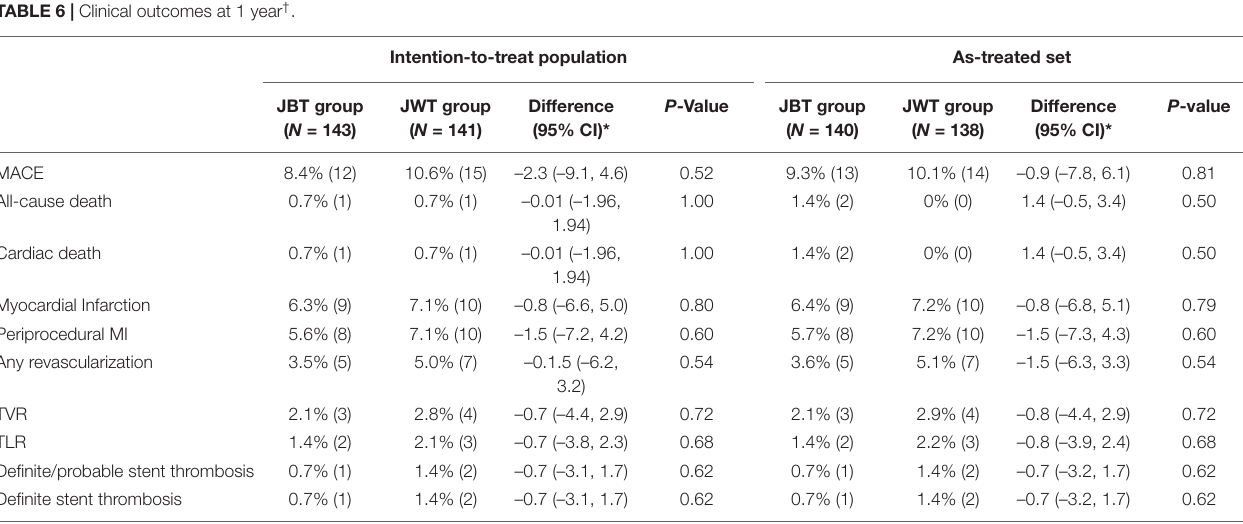
FIGURE 3 | MACE-free survival rate at 1 year. The rate was 91.6% in the JBT group, and it was 89.4% in the JWT group ( p = 0.52). MACE: major adverse cardiac event; JBT: jailed balloon technique; JWT: jailed wire technique. TABLE 6 | Clinical outcomes at 1 year †